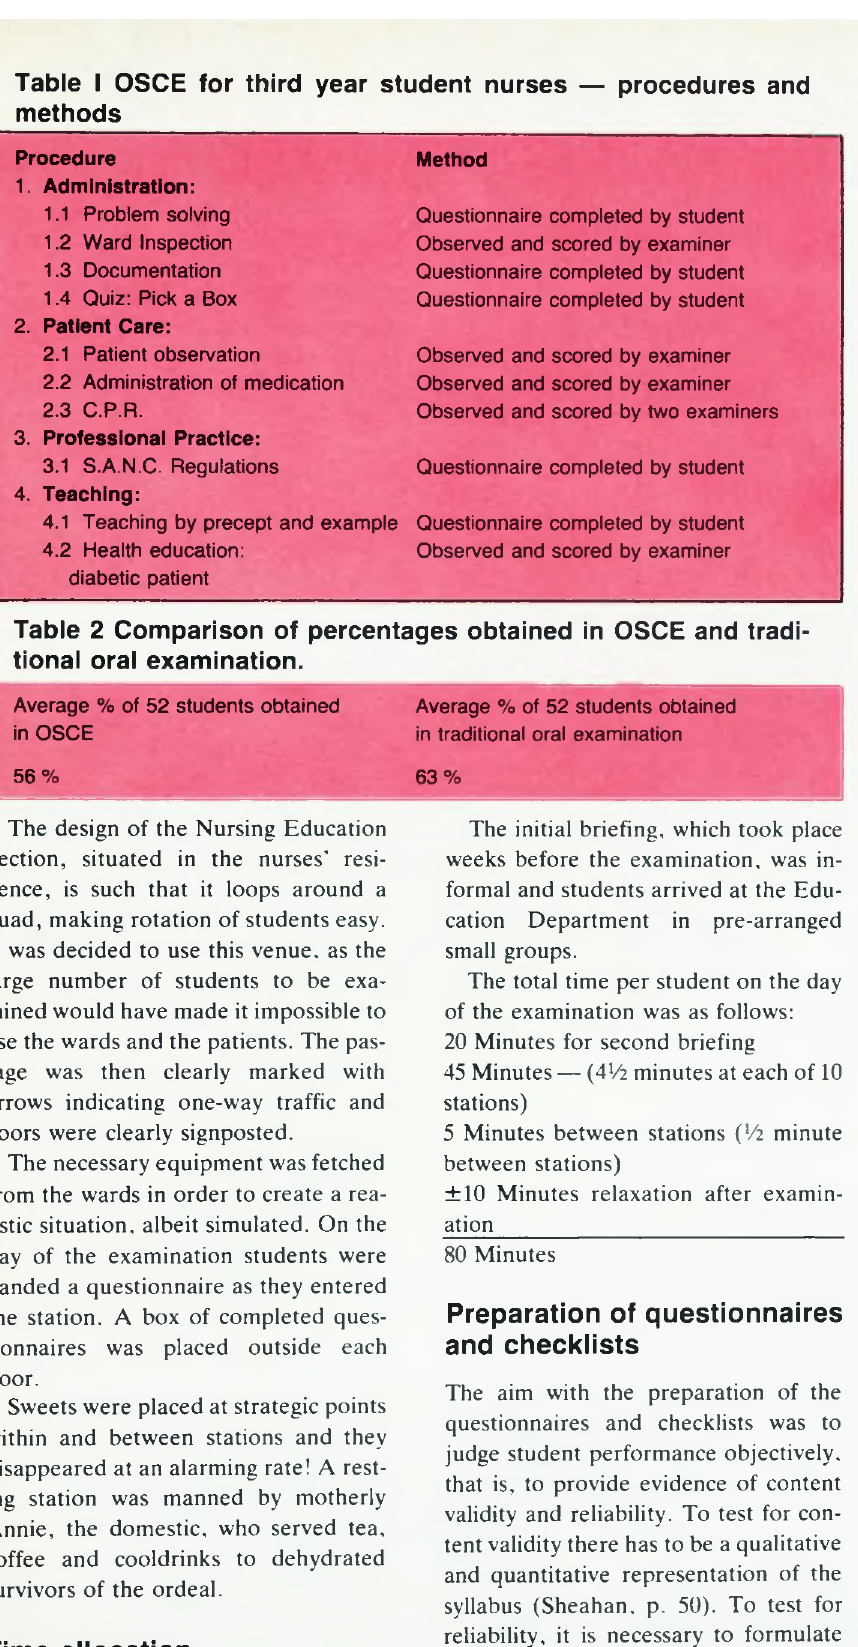
Table 1 OSCE for third year student nurses — procedures and methods